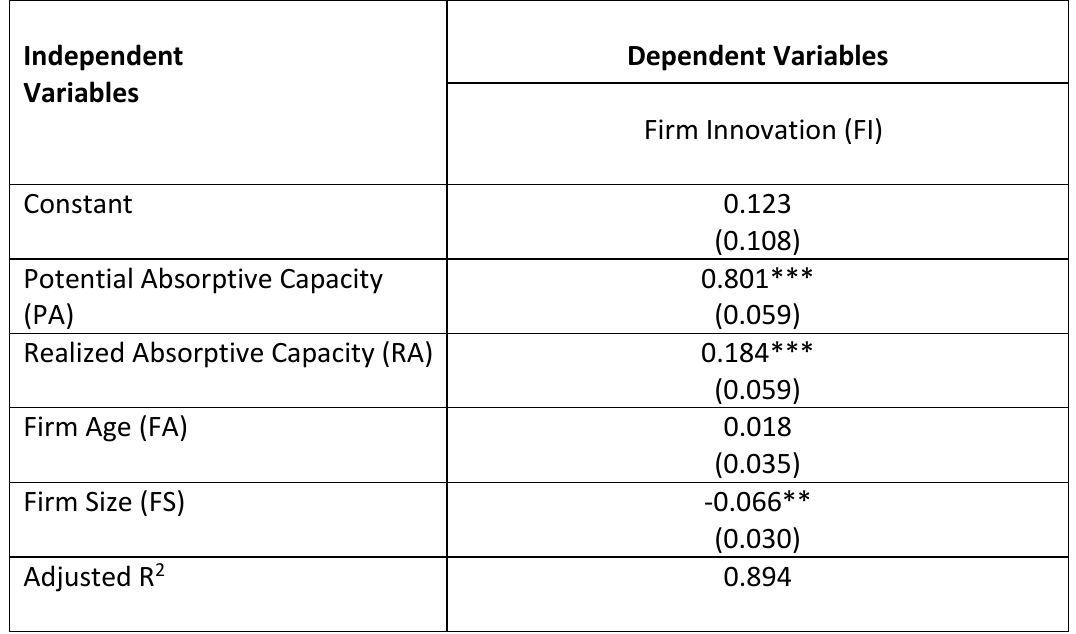
Table 5: Results of Regression